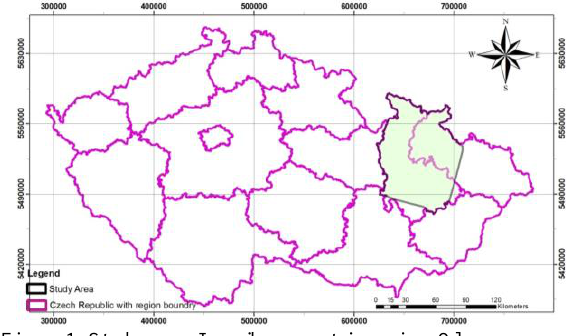
Figure 1. Study area: Jeseniky mountain region, Olomouc. This region is characterised by coniferous forest (Pinus sylvestris L.and Picea abies L. Karst.) and large aapa mires. Deciduous trees mainly Betula spp. occur to a lesser extent and located in the northern boreal vegetation zone. Highest fells and alpine vegetation are found in the north-western part of the study region in the Jeseniky mountain area. A large number of lichen pastures with forest are located in the eastern and north- eastern mountainous part of the Olomouc region. The most important late winter pastures with arboreal lichens are located in the western, central and southern parts of the Olomouc Region (Bao & Wang, 2000). Summer and autumn pasture with vegetation are consisting in mires, lake and riversides. Moist forest and fresh forest are present in the north-eastern, south- western, eastern and western parts of the Olomouc Region (Boori & Amaro, 2010).